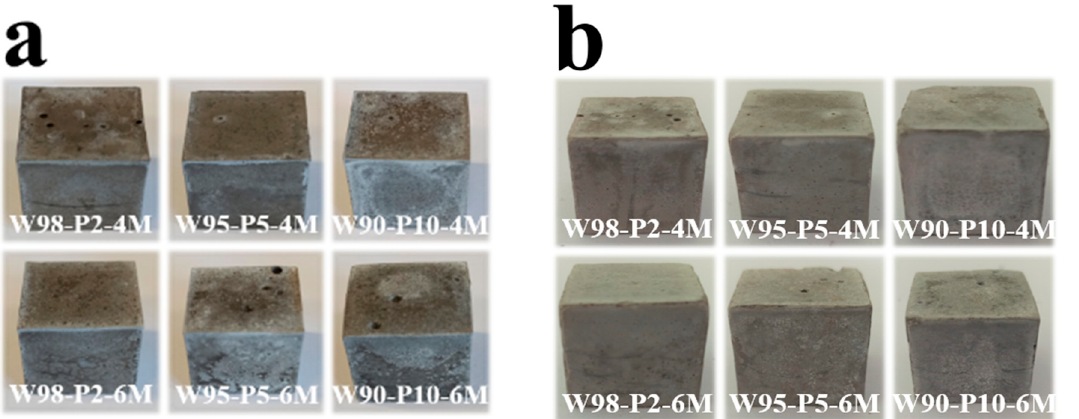
Figure 4. AA-WBA/PV specimens ( a ) before and ( b ) after the boiling test. Table 3. Selective chemical extraction